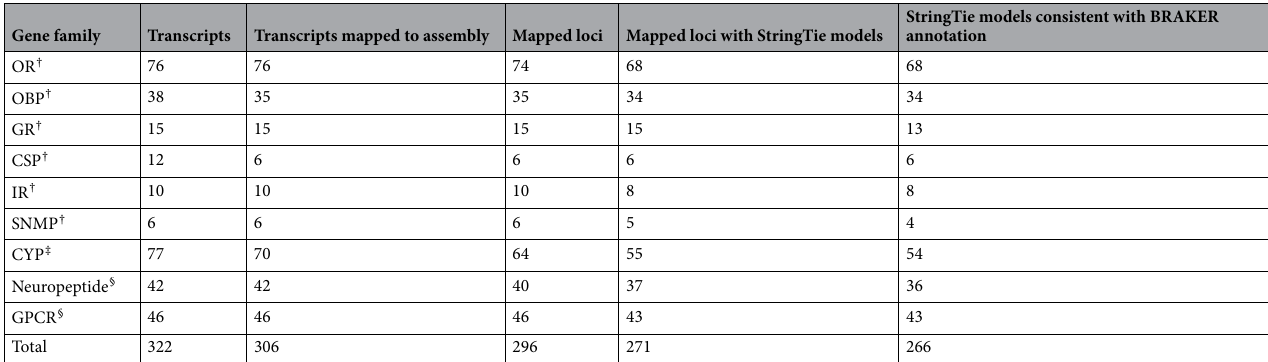
Table 4. Presence of functionally-relevant gene sets in the RPW pseudo-haplotype1 assembly and annotation. † § ‡ Curated gene set from Antony et al. 9 . Curated gene set from Antony et al. 53 . Curated gene set from Zhang et al. 11 . Numbers of transcripts, numbers of transcripts mapped to the pseudo-haplotype1 assembly, and numbers of loci in the pseudo-haplotype1 assembly are based on the original transcripts reported in Antony et al. 9 and Zhang et al. 11 . Numbers of loci that are consistent with the BRAKER annotation of pseudo- haplotype1 are based on the corresponding StringTie transcript model overlapping transcripts from Antony et al. 9 , Antony et al. 53 and Zhang et al. 11 to correct for orientation strand orientation artifacts in the Antony et al. 9 transcriptome and provide a uniform set of gene structures across curated gene